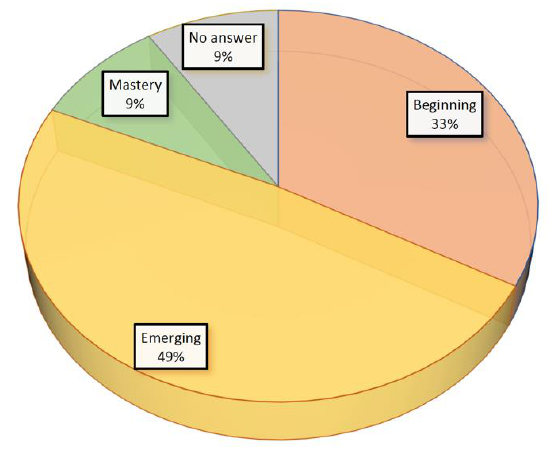
Figure 4. Results obtained from the analysis of activity 2.